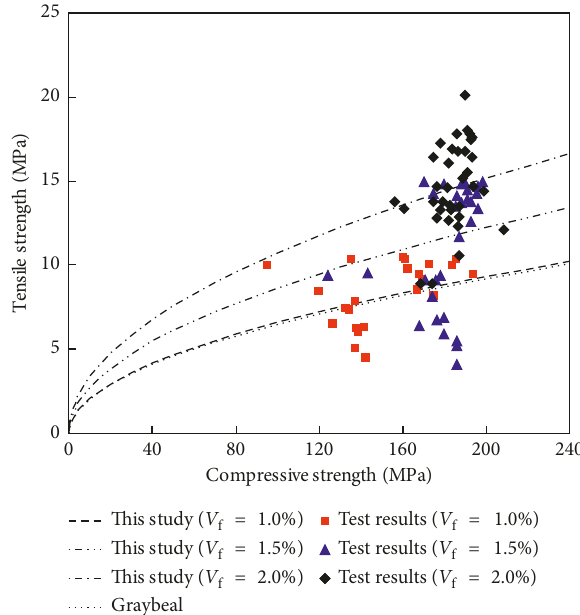
Figure 9: Prediction of the tensile strength by using the com- pressive strength and steel fiber content of the